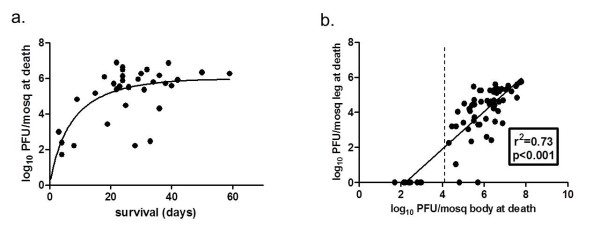
WNV titers in Cx. pipiens mosquitoes at the time of death. (a) Data points represent individual mosquitoes and the line represents the best-fit relationship between WNV body titer and time of death. (b) Relationship between WNV body titer and WNV leg titer in individual mosquitoes. The dotted line refers to the threshold body titer required for WNV dissemination (4.2 log10 pfu) and the linear regression analysis was completed for all values above that threshold.